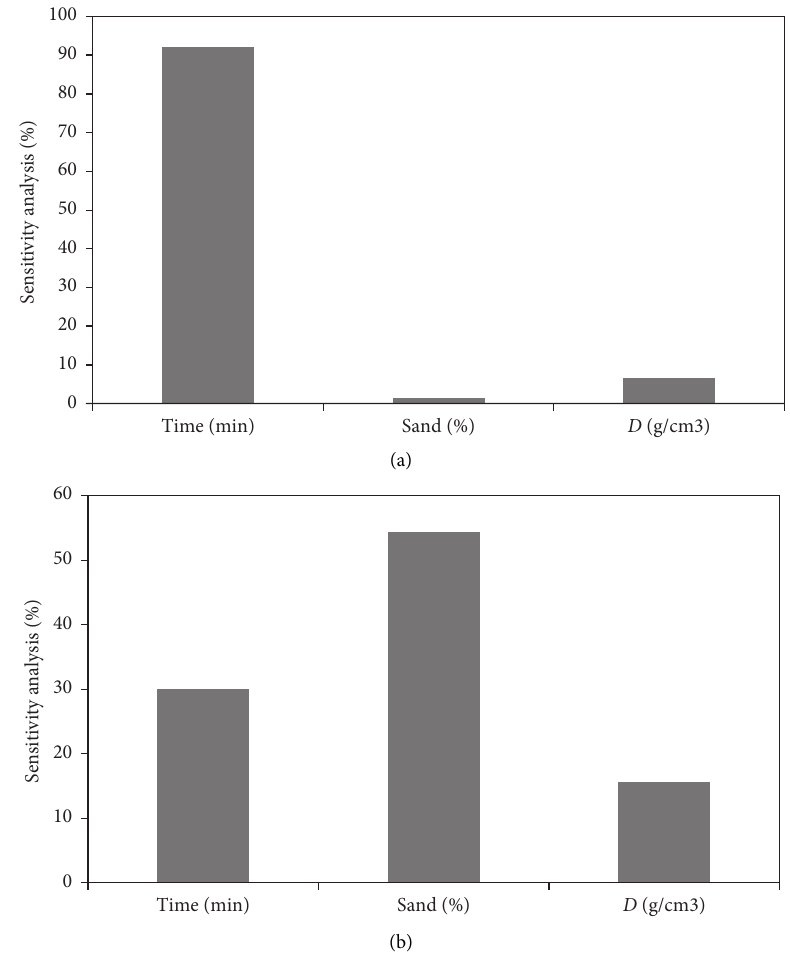
Figure 13: Results of the sensitivity analysis based on (a) ANN and (b)